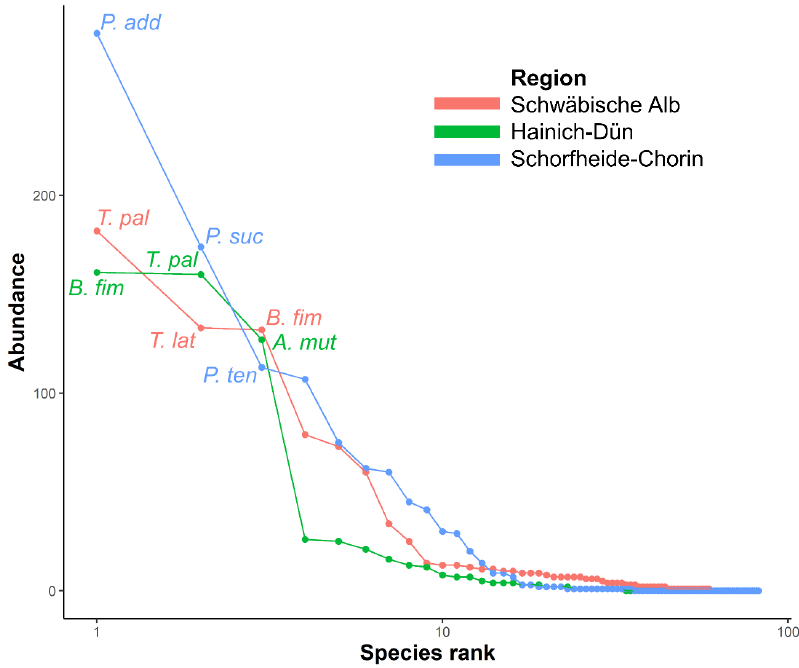
Figure 3. Rank abundance curves showing the abundance of rove beetle species observed on piglet cadavers at 65 forest sites separated for each study region: Schwäbische Alb, Hainich-Dün and Schorfheide-Chorin. The three most abundant species are labeled for each study region ( P. add = P. addendus , P. suc = P. succicola , P. ten = P. tenuicornis , T. pal = T. pallipes , T. lat = T. laticollis , B. fim = B. fimetarius , A. mut = A. mutator ), N = 2692 individuals.